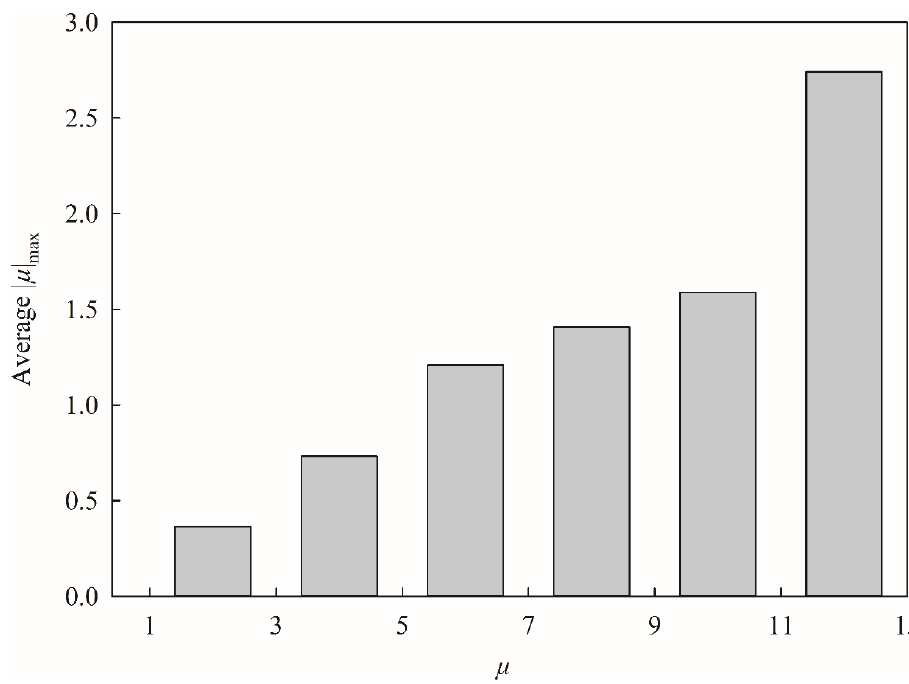
Figure 9. Histogram of average | µ | max versus the distribution of µ .